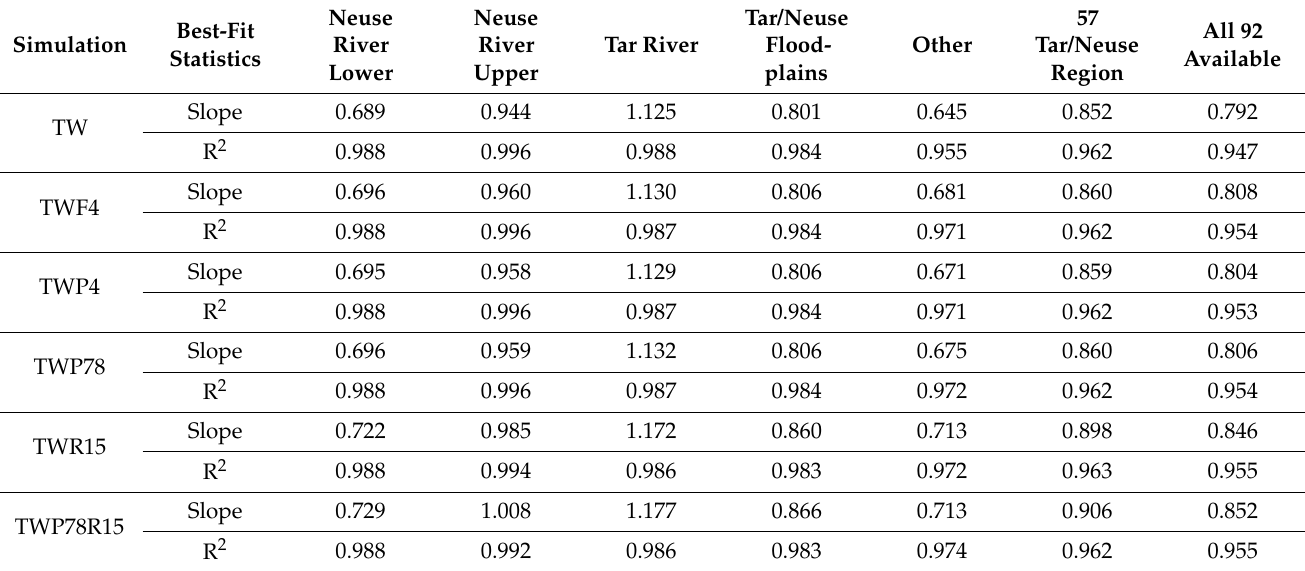
Table 4. Comparison of linear best-fit statistics of HWM scatter plots by location